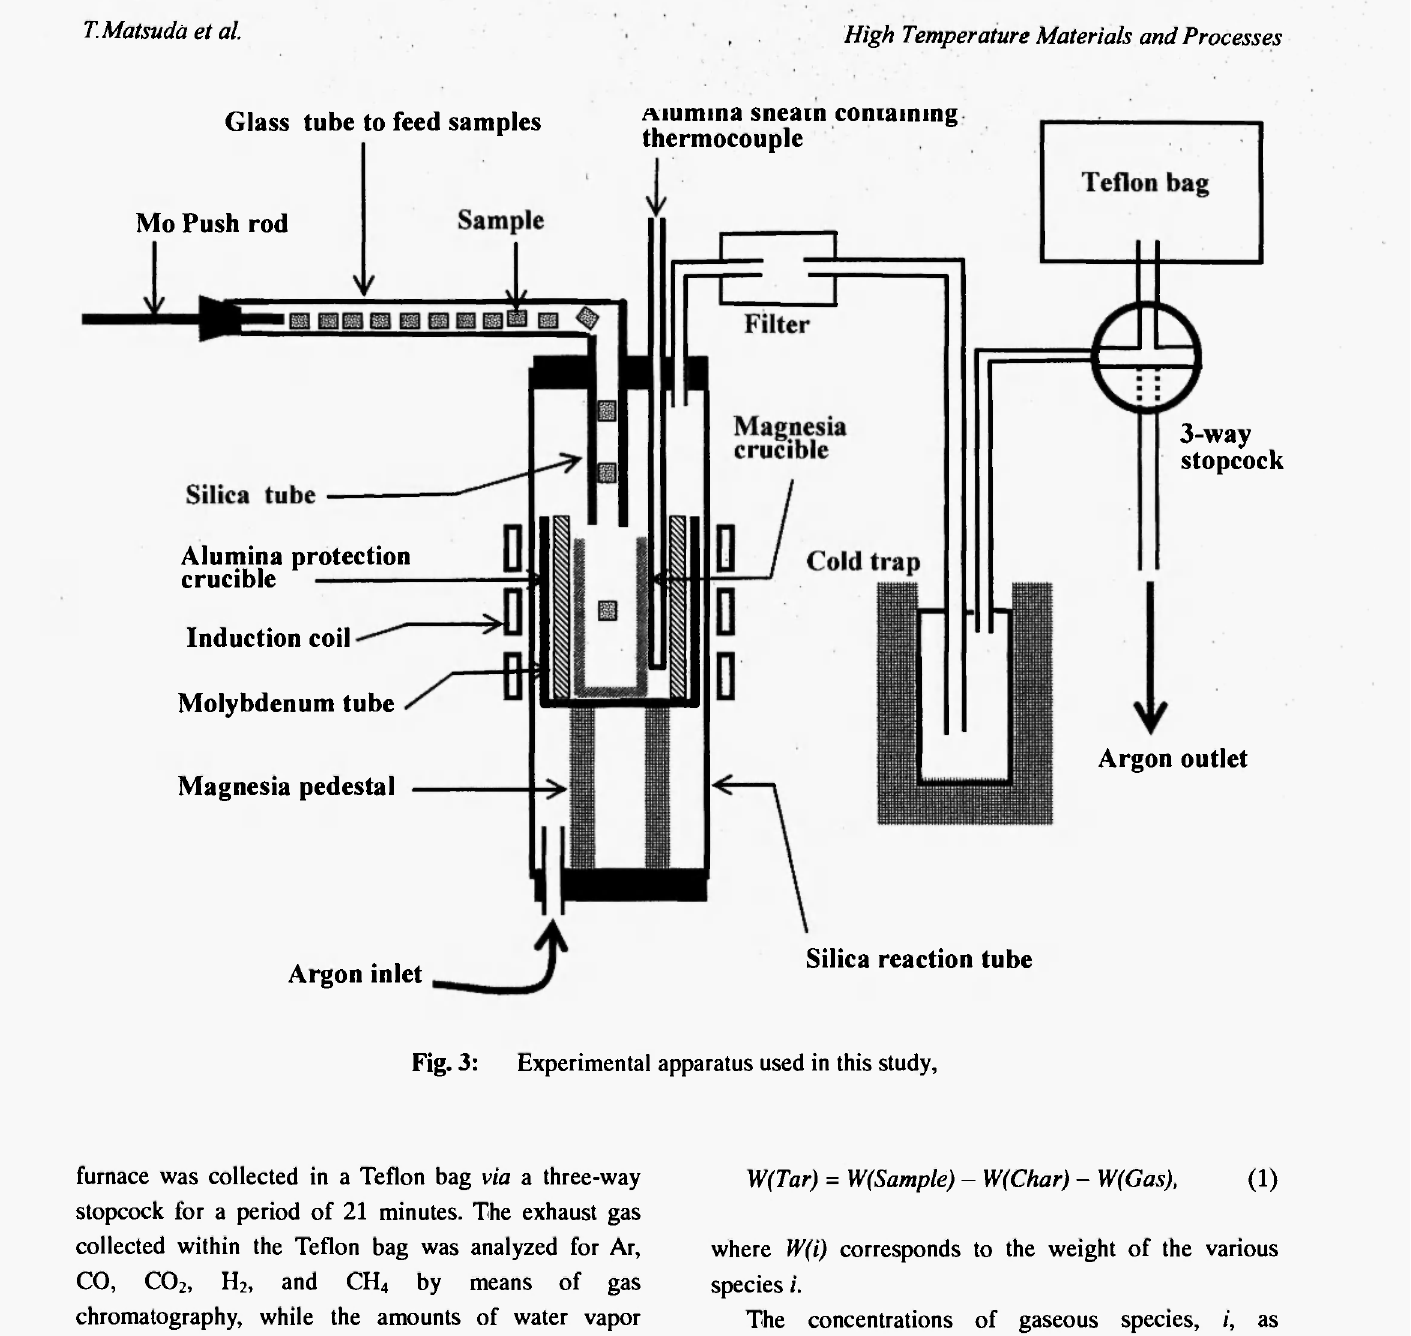
Fig. 3: Experimental apparatus used in this